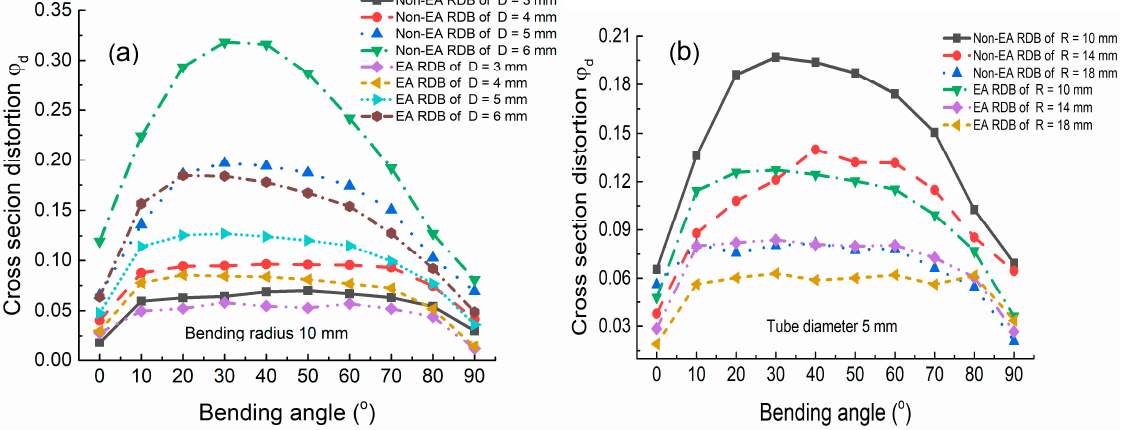
Figure 7. The influence of ( a ) tube diameter and ( b ) bending radius on cross-section distortion in non-EA RDB and EA RDB.